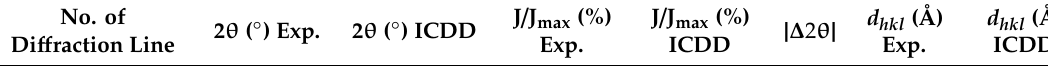
Table 8. Comparison of experimental data with data from the ICDD database for the drugs Metafen, Palgotal, Antidol 15, FluControl, and